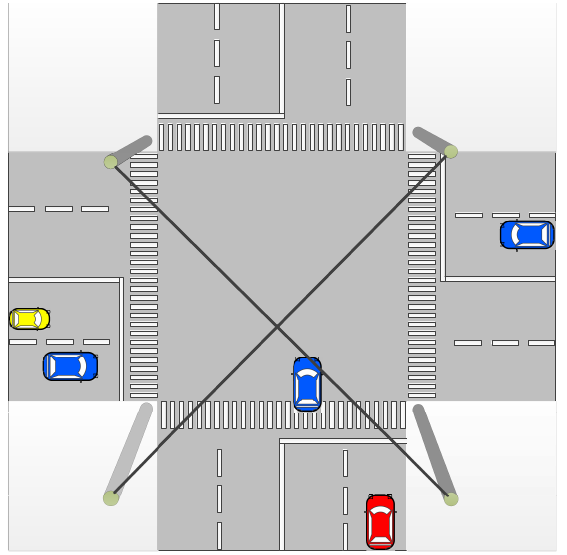
Figure 3. Simulation scenario of an intersection with five vehicles. The simulated RADAR is mounted above the ground (represented with four poles) on the cross section. The RADAR is assumed to have 360 ◦ field of view. The vehicles represent the state of their trajectory at random time t